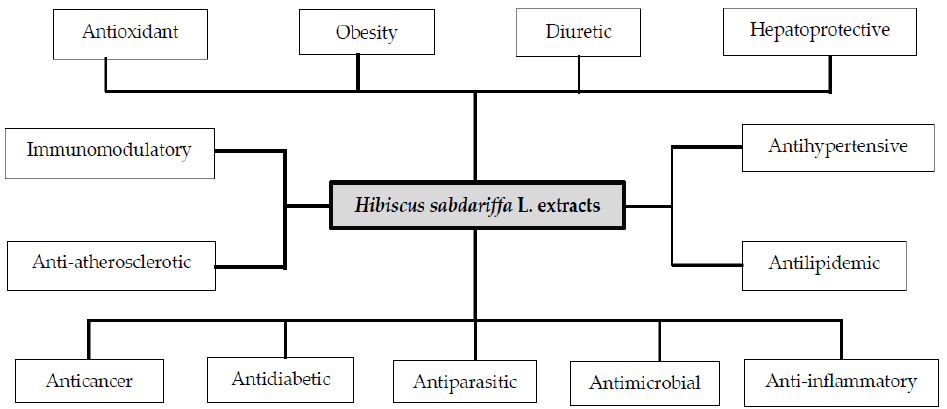
Figure 1. Therapeutic and/or pharmacological properties of Hibiscus sabdariffa L. extracts. Table 1. Nutritional compounds of Hibiscus sabdariffa L .